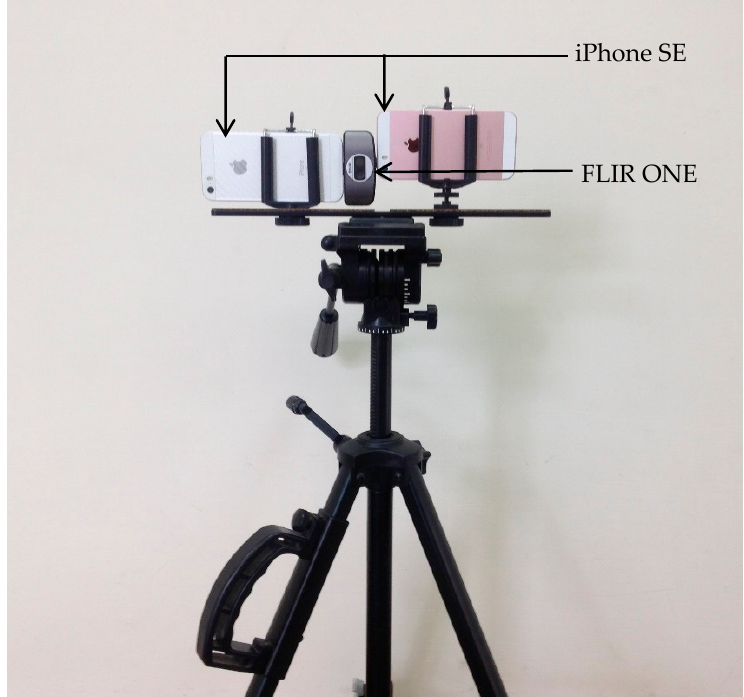
Figure 1. Arrangement of experimental equipment.